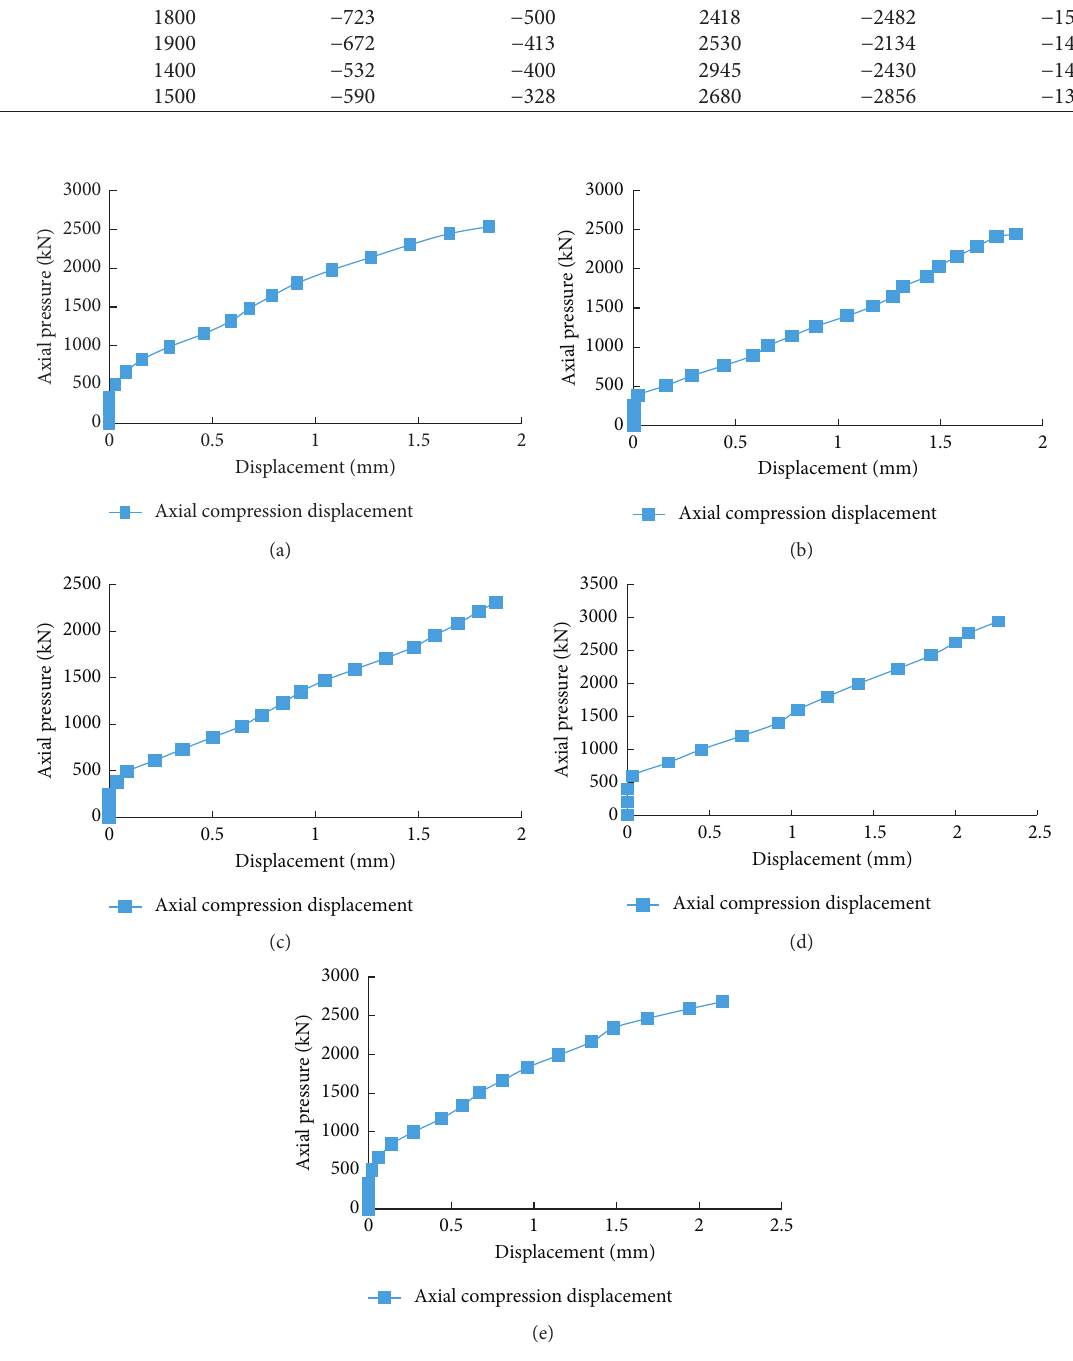
Figure 4: Load-displacement curve. (a) W1 specimen; (b) W2 specimen; (c) W3 specimen; (d) W4 specimen; (e) W5